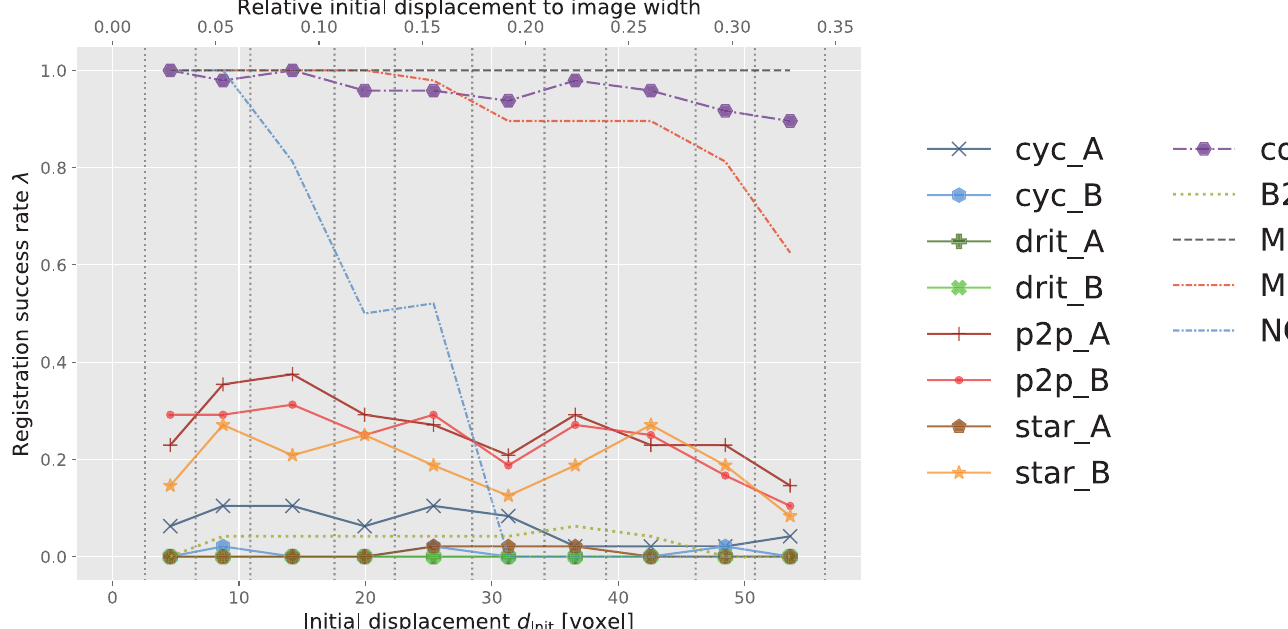
Fig 9. Success rate of the observed 3D registration approaches on Radiological data. x -axis : initial displacement d Init between moving and fixed images, discretised into 10 equally sized bins (marked by vertical dotted lines). y -axis : success rate λ within each bin (averaged over 3 folds). In the legend, cyc , drit , p2p , star and comir denote CycleGAN, DRIT++, pix2pix, StarGANv2, and CoMIR methods respectively. Suffix _A (resp. _B) denotes that generated Modality A (resp. B) is used for the (monomodal) registration. B2A denotes registration of the original multimodal images, without using any modality translation. MI , MIND and NGF represent using MI maximisation, MIND and maximisation of the similarity of NGF for registration,